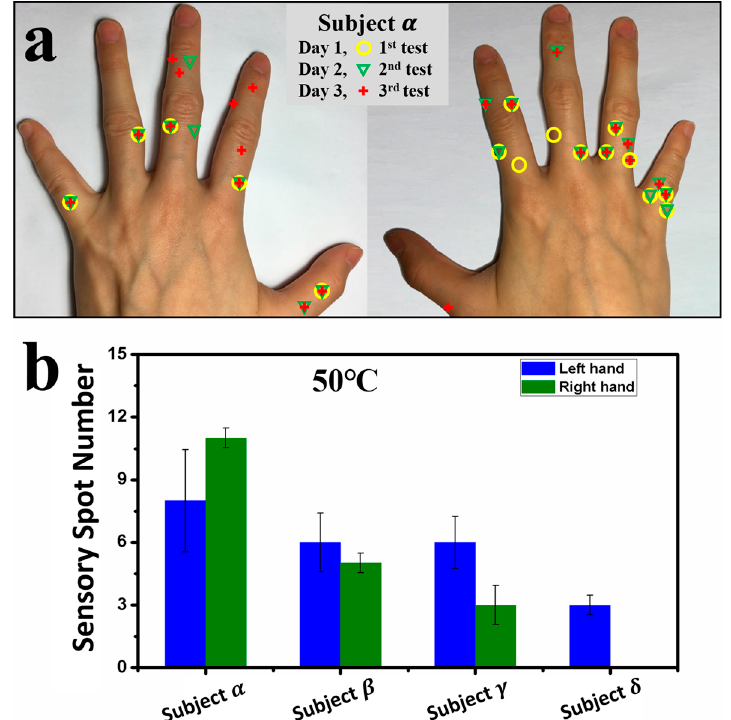
Figure 3. Results of locations and numbers of sensory spots on the backsides of the fingers of subjects α , β , γ , and δ . ( a ) Photographs for the locations of sensory spots responded to at 50.0 °C on the backsides of the fingers for subject α . Yellow circles highlight the first test result, green triangles highlight the second test result, and red crosses highlight the third test result; ( b ) Average numbers of sensory spots responded to at 50.0 °C on the backsides of fingers for the four subjects.